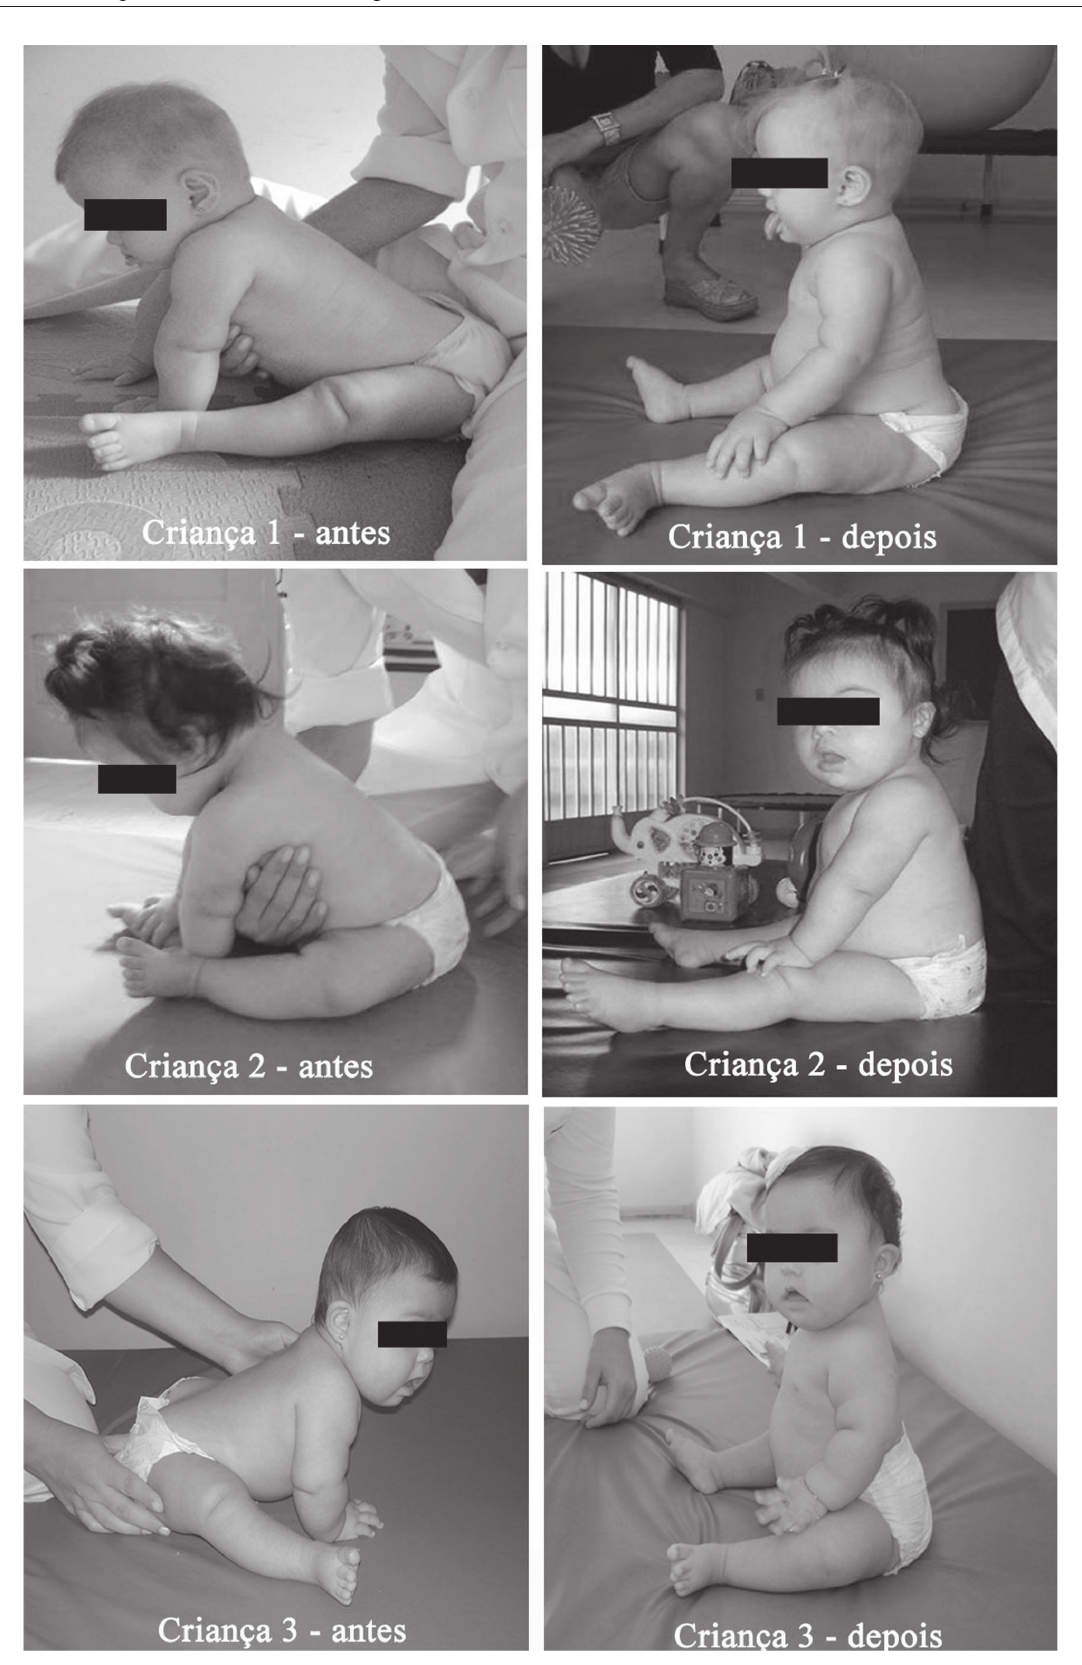
Figura 2 - Aquisição do sentar independente – média de sessões: 15 (± 2) Fisioter Mov. 2010